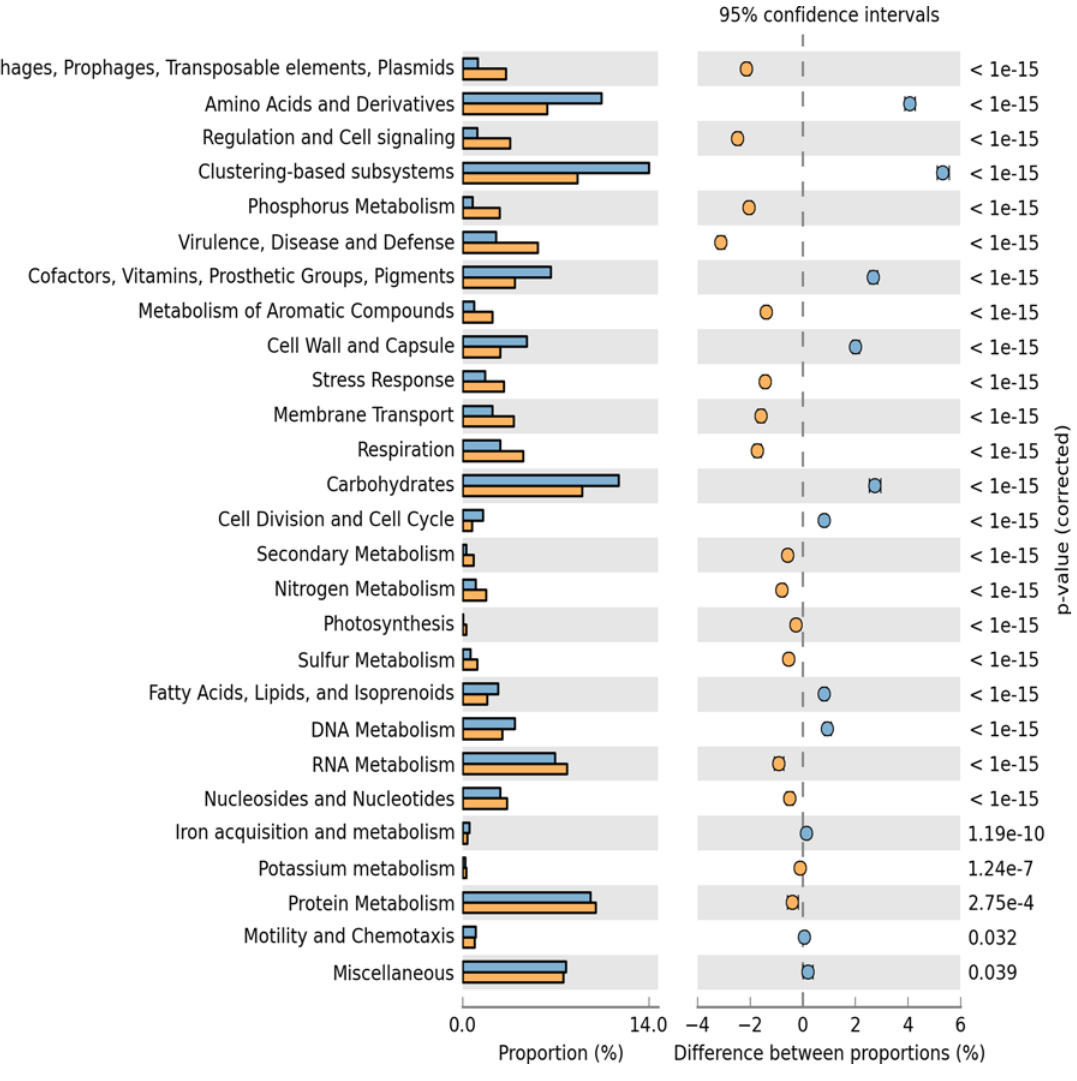
Fig 4. Significant SEED subsystem differences as a result of a Fisher exact test between the MSS and RAW metagenomes conducted with the STAMP program. Enrichment of SEED subsystem in the RAW metagenome has a positive difference between proportions (blue circles), whereas enrichment of SEED subsystem in the MSS metagenome has a negative difference between proportions (orange circles). Bars on the left represent the proportion of each subsystem in the data. Subsystems difference with a p value of > 0.05 were considered to be